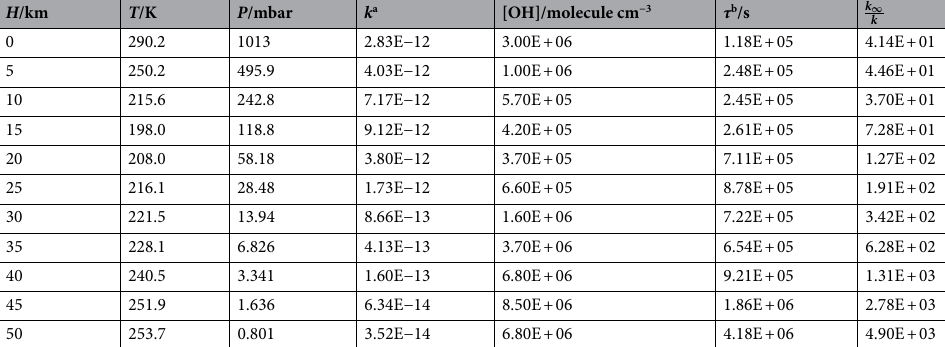
Table 5. The rate constant of the N 2 H 4 + OH reaction for Path 1 + Path 2, the concentration of hydroxyl radical in different altitudes, and lifetimes of N 2 H 4 in the atmosphere in an ambient of atmospheric hydroxyl radical as functions of Height. The altitude (H), pressure (P), the temperature (T), and the OH concentration ([OH]) in this Table are from reference 75 . a k is the bimolecular rate constant at the mentioned temperature and pressure. b τ = 1 k [ OH ] is the lifetime of N 2 H 4 in the atmospheric concentration of